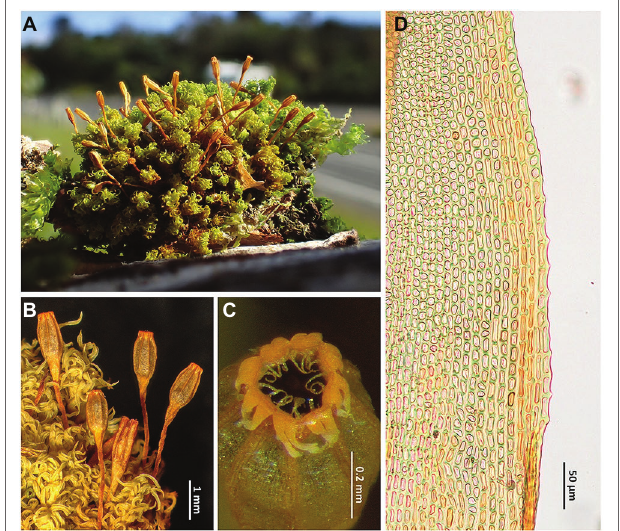
FIGURE 3 | Rehubryum bellii . (A) General aspect of a dry cushion in the field. (B) Detail of the habit showing the upper leaves when dry and several sporophytes, most of them with mature, recently opened capsules. (C) Mouth of a capsule when dry, showing a peristome with 8 pairs of teeth, split almost to the base, and 16 well-developed segments. (D) Detail of the leaf lamina margin just above the basal leaf showing the submarginal band of elongated cells and the papillose marginal cells. (A) image taken in Mount Taranaki NP (Lara 1601/57, MAUAM); (A–C) from Garilleti 2016-045b (Garilleti’s personal Herb.); and D from Garilleti 2016–104 (Garilleti’s personal